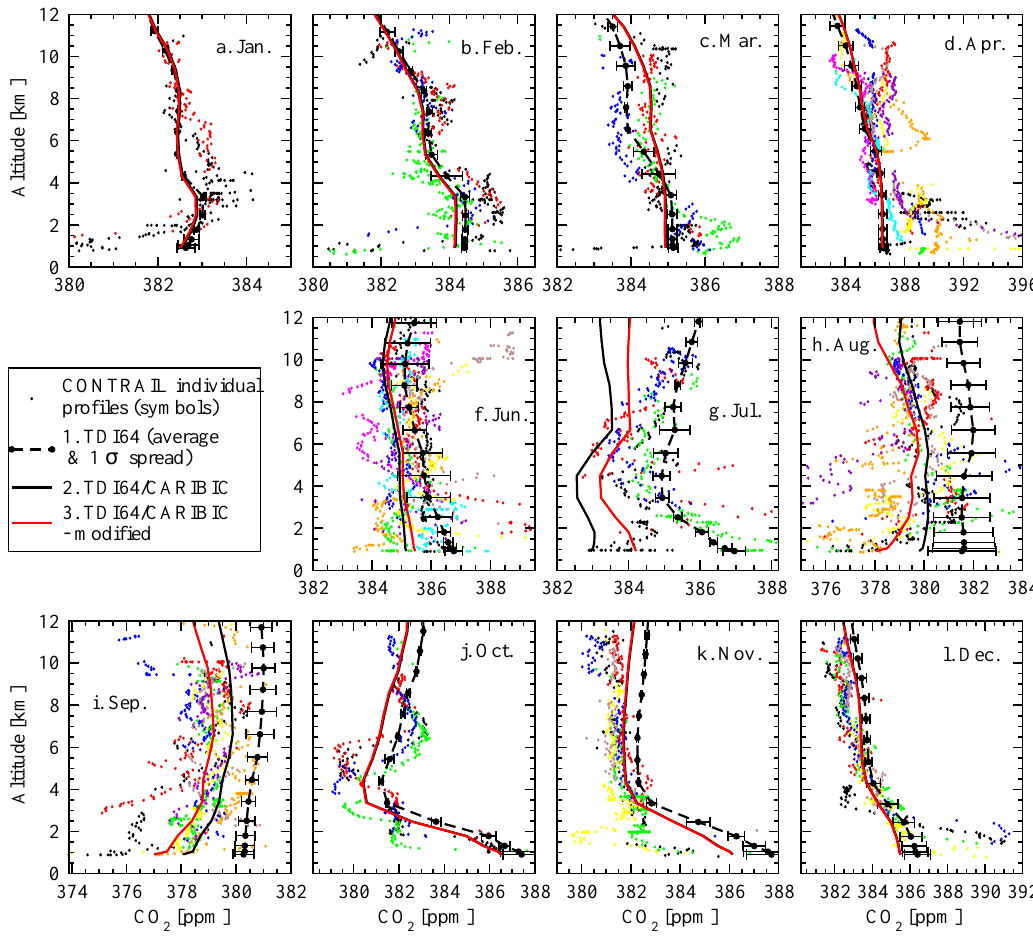
Fig. 4. Validation of TDI predicted surface fluxes by comparing the ACTM simulated CO 2 concentrations with CONTRAIL measurements of vertical profiles over Delhi. While individual CONTRAIL profiles are shown within each panel for a month, the ACTM profiles are shown as average values (and 1 σ spread for TDI64 case only) corresponding to 3 inversion fluxes (legend #1–3) at model vertical resolution. All the model results are adjusted to 382.5ppm at 8km altitude for the month of January, and variable x-axis range is adopted to reveal maximum information content in each monthly set of profiles. Comparison of seasonal or 3-monthly mean profiles is shown in Fig. 5, exhibiting model simulations using TDI64/CARIBIC fluxes agree within 1ppm at all heights in most seasons. The solid black line is visible separately from the solid red line only for